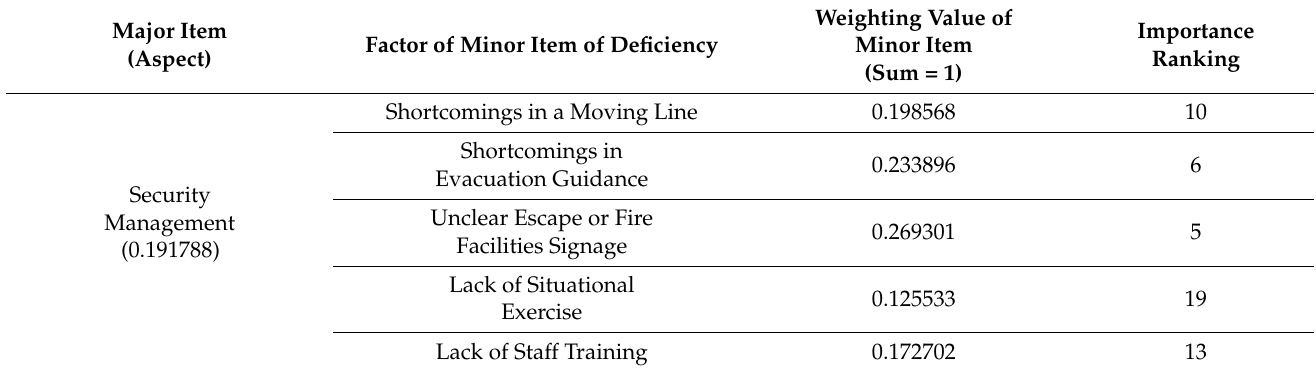
Table 7. Weighting values for security management.